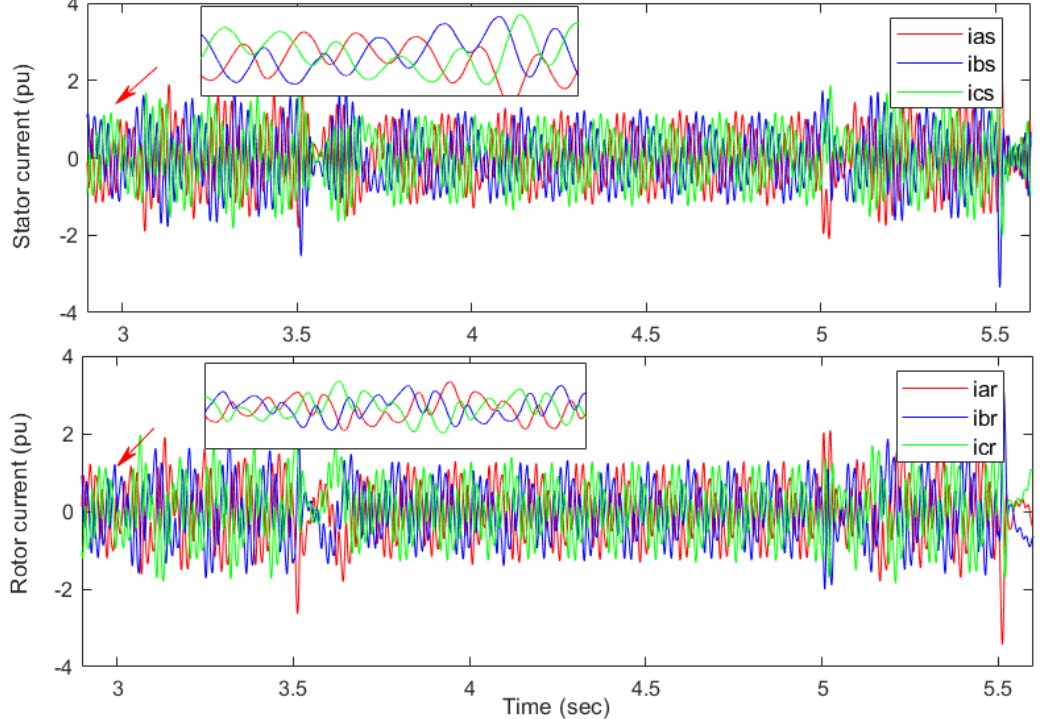
Figure 15. Simulation results of the stator and rotor currents under unbalanced grid voltage conditions and influence of SPV (PI controller case).